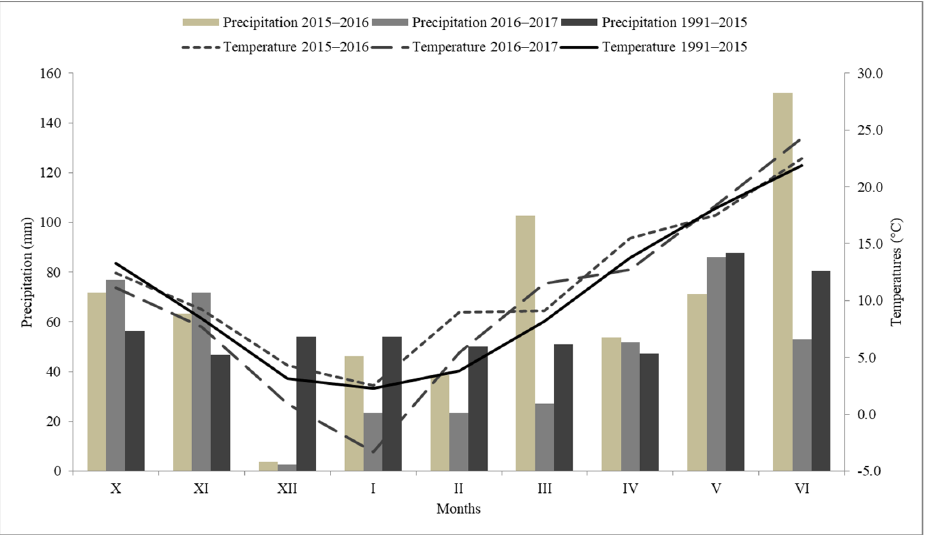
Figure 2. Average monthly mean air temperature (°C) and precipitation sum (mm) over a long-term period and during the examination.